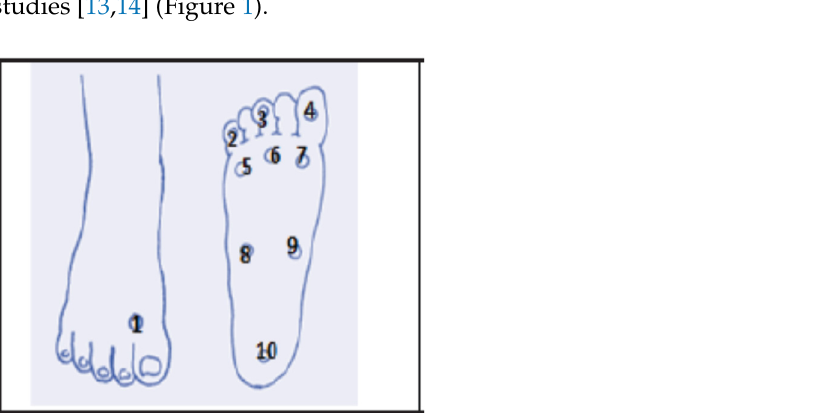
Figure 1. Points for assessing plantar sensitivity. Forefoot (1 to 7), midfoot (8 and 9), hindfoot (10).